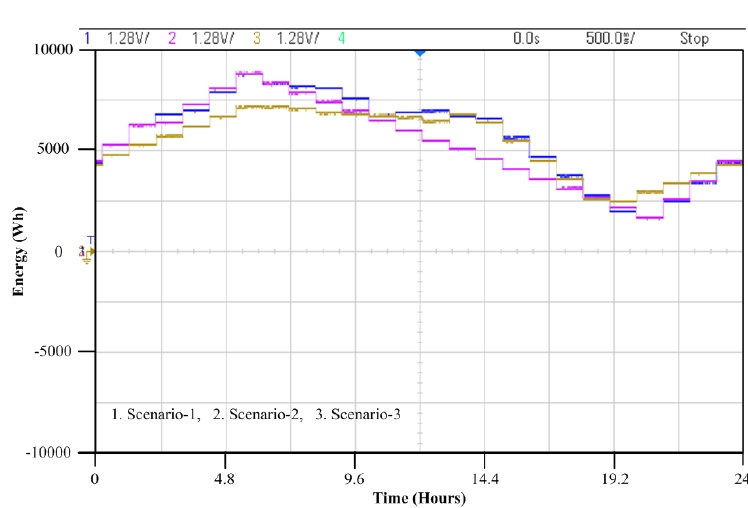
Figure 18. BESS power for scenario-3.